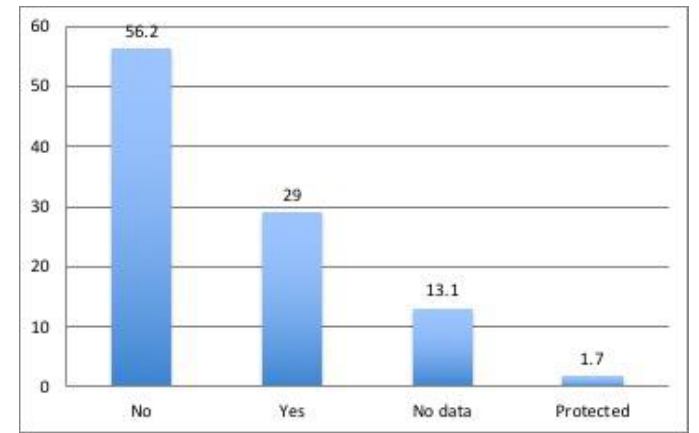
Figure 2 . Messages sent from Twitter accounts in 2017 (percentages).